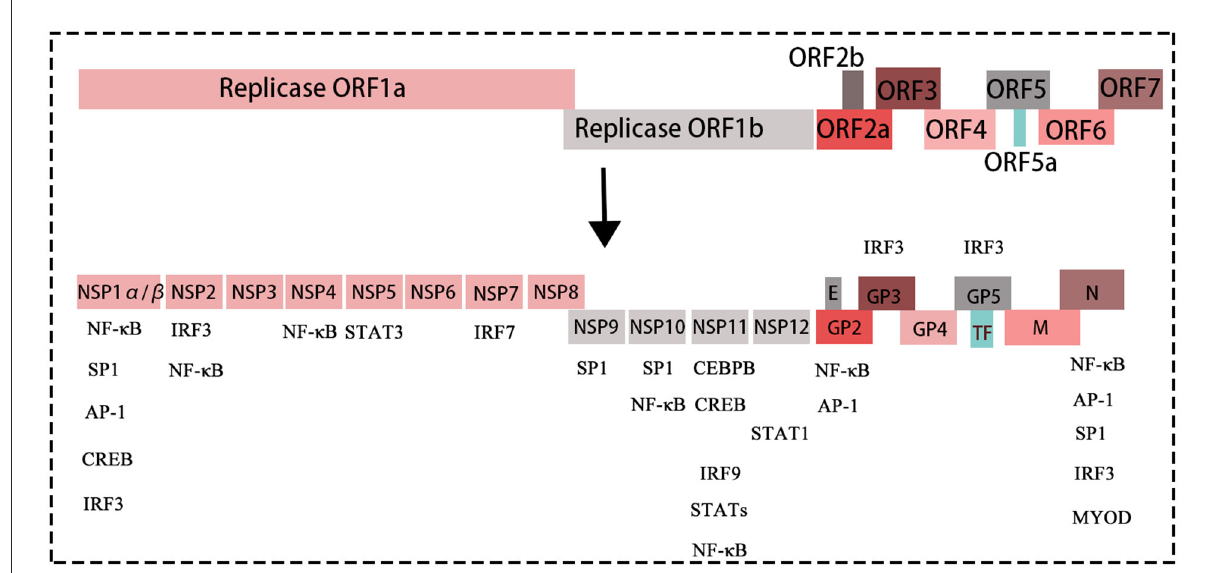
FIGURE1 The structure of the PRRSV genome, with different colored boxes representing different genes of the virus. The proteins translated by each gene of PRRSV. The genes without boxes below are transcription factors, which can bind/interact with structural proteins and non-structural proteins of PRRSV, thus affecting replication of